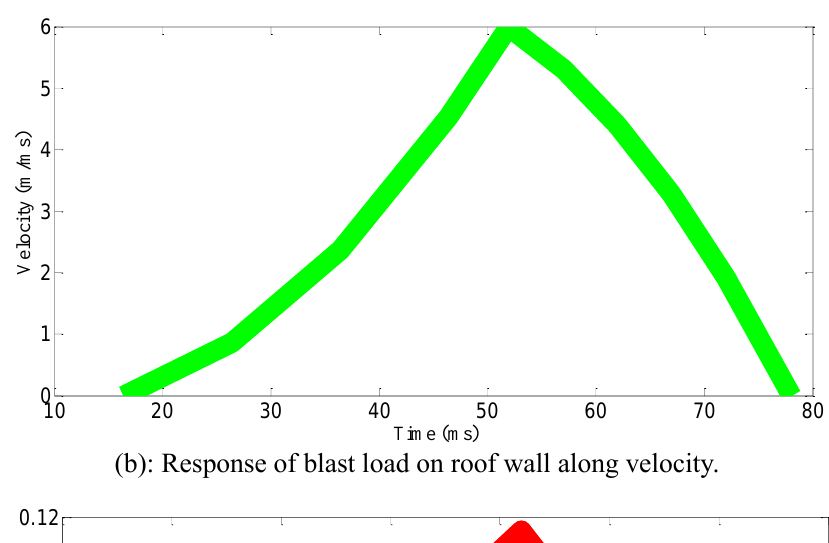
(b): Response of blast load on roof wall along velocity.